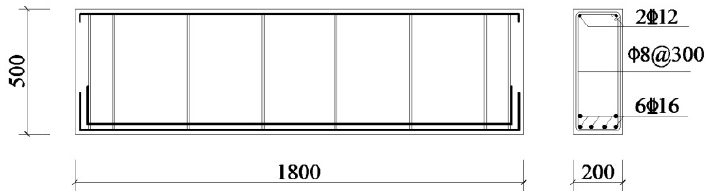
Figure 3. Cross-sectional view of the DSRC deep beam for stirrup rate ρ v = 0.168%.